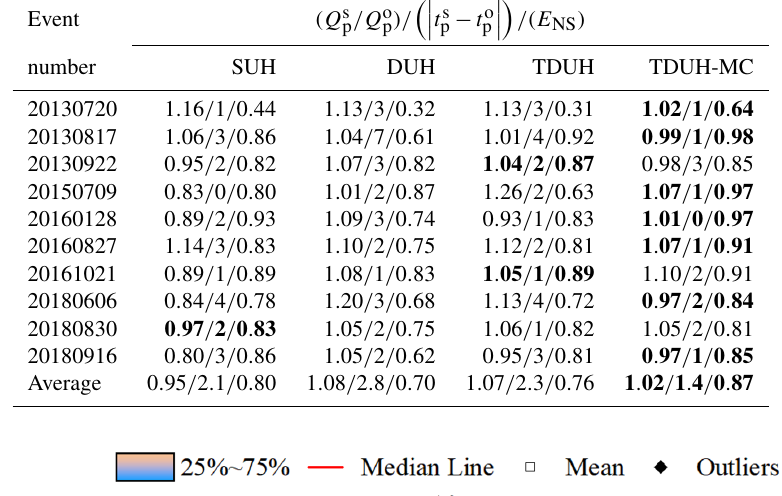
Table 6. Comparison of four routing methods for the Qin River basin. The values in bold mean the result performed the best among the four methods.